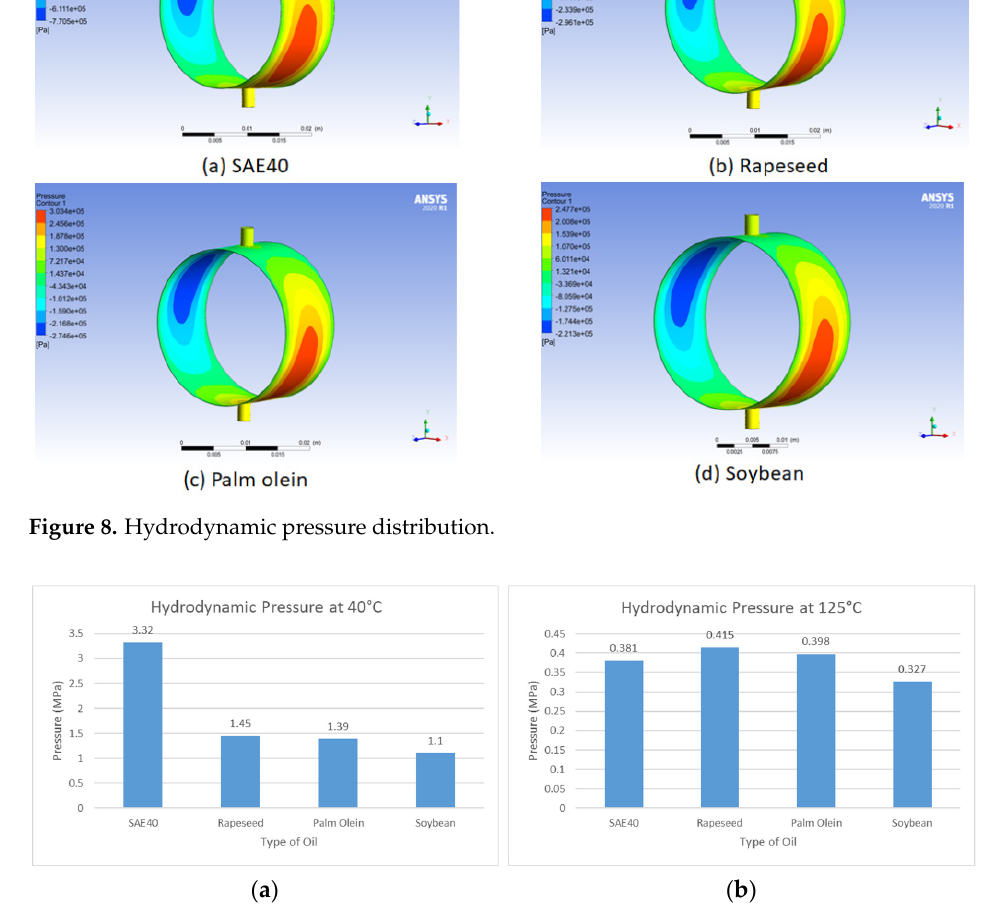
Figure 9. Comparison of maximum hydrodynamic pressure.